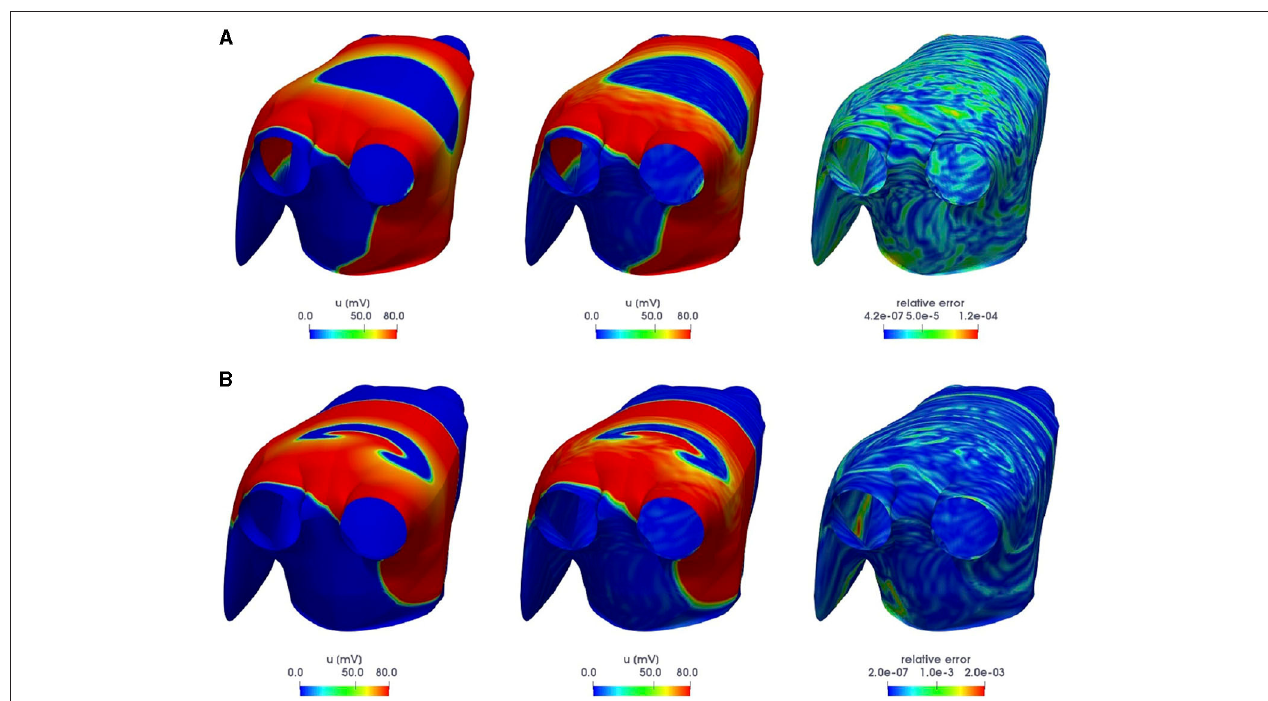
FIGURE 11 | Test 3 : FOM (left) and POD-DL-ROM (center) solutions, the latter obtained with n = 4 and N = 1,024, together with ǫ k (right), for the testing-parameter instances µ test = (0.3162,0.8638,0.6864) cm (A) and µ test = (0.2508,0.7932,0.8895) cm (B) at t = 300.8